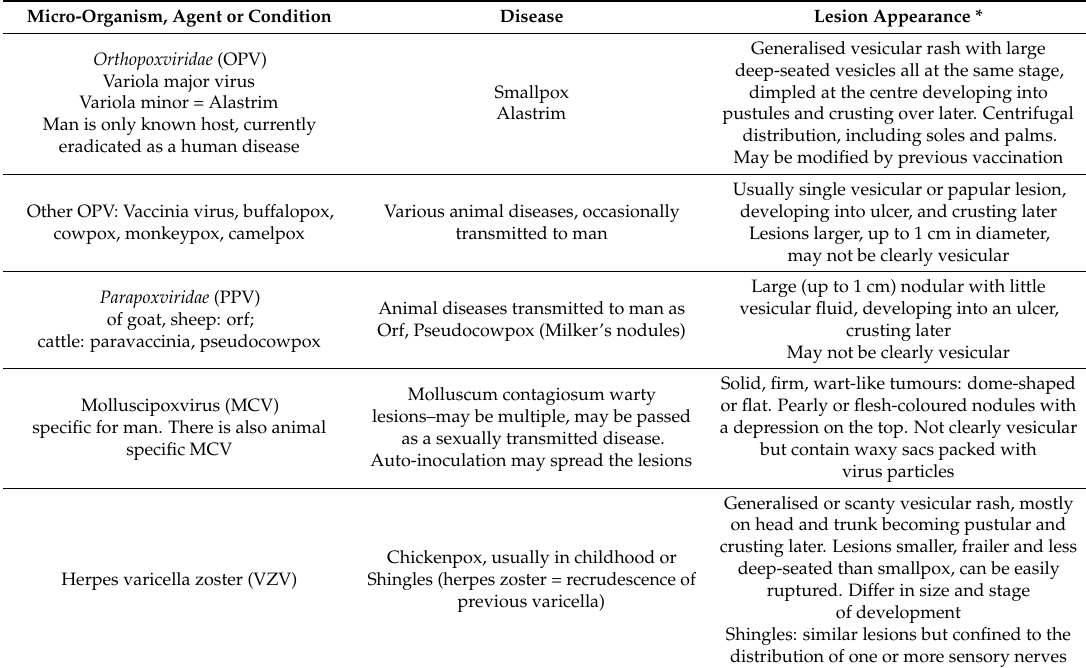
Table 1. Skin Lesions of Man and their infective or Non-Infective